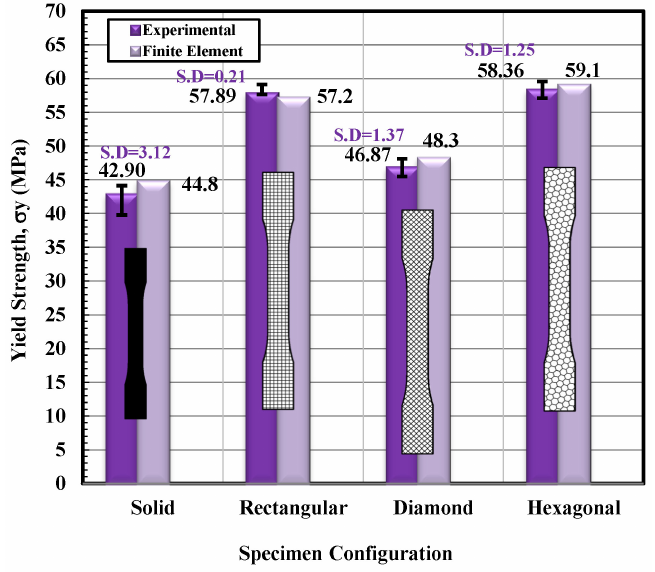
Figure 17. Yield strength versus specimen configuration for both experimental and finite element analysis.